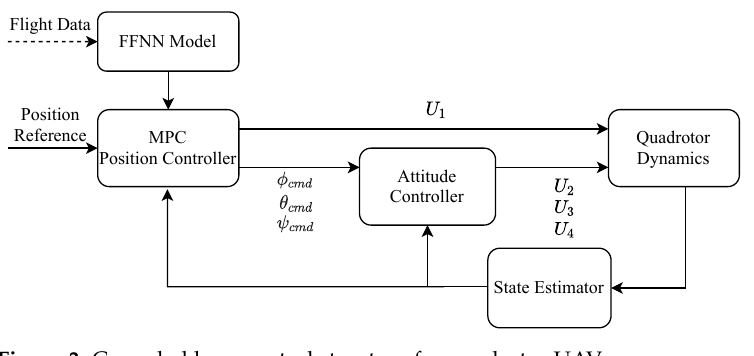
Figure 3. Cascaded loop control structure for quadrotor